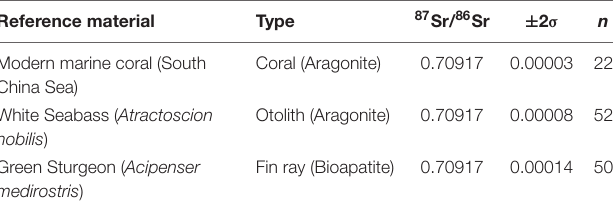
TABLE 3 | Strontium isotope in-house reference